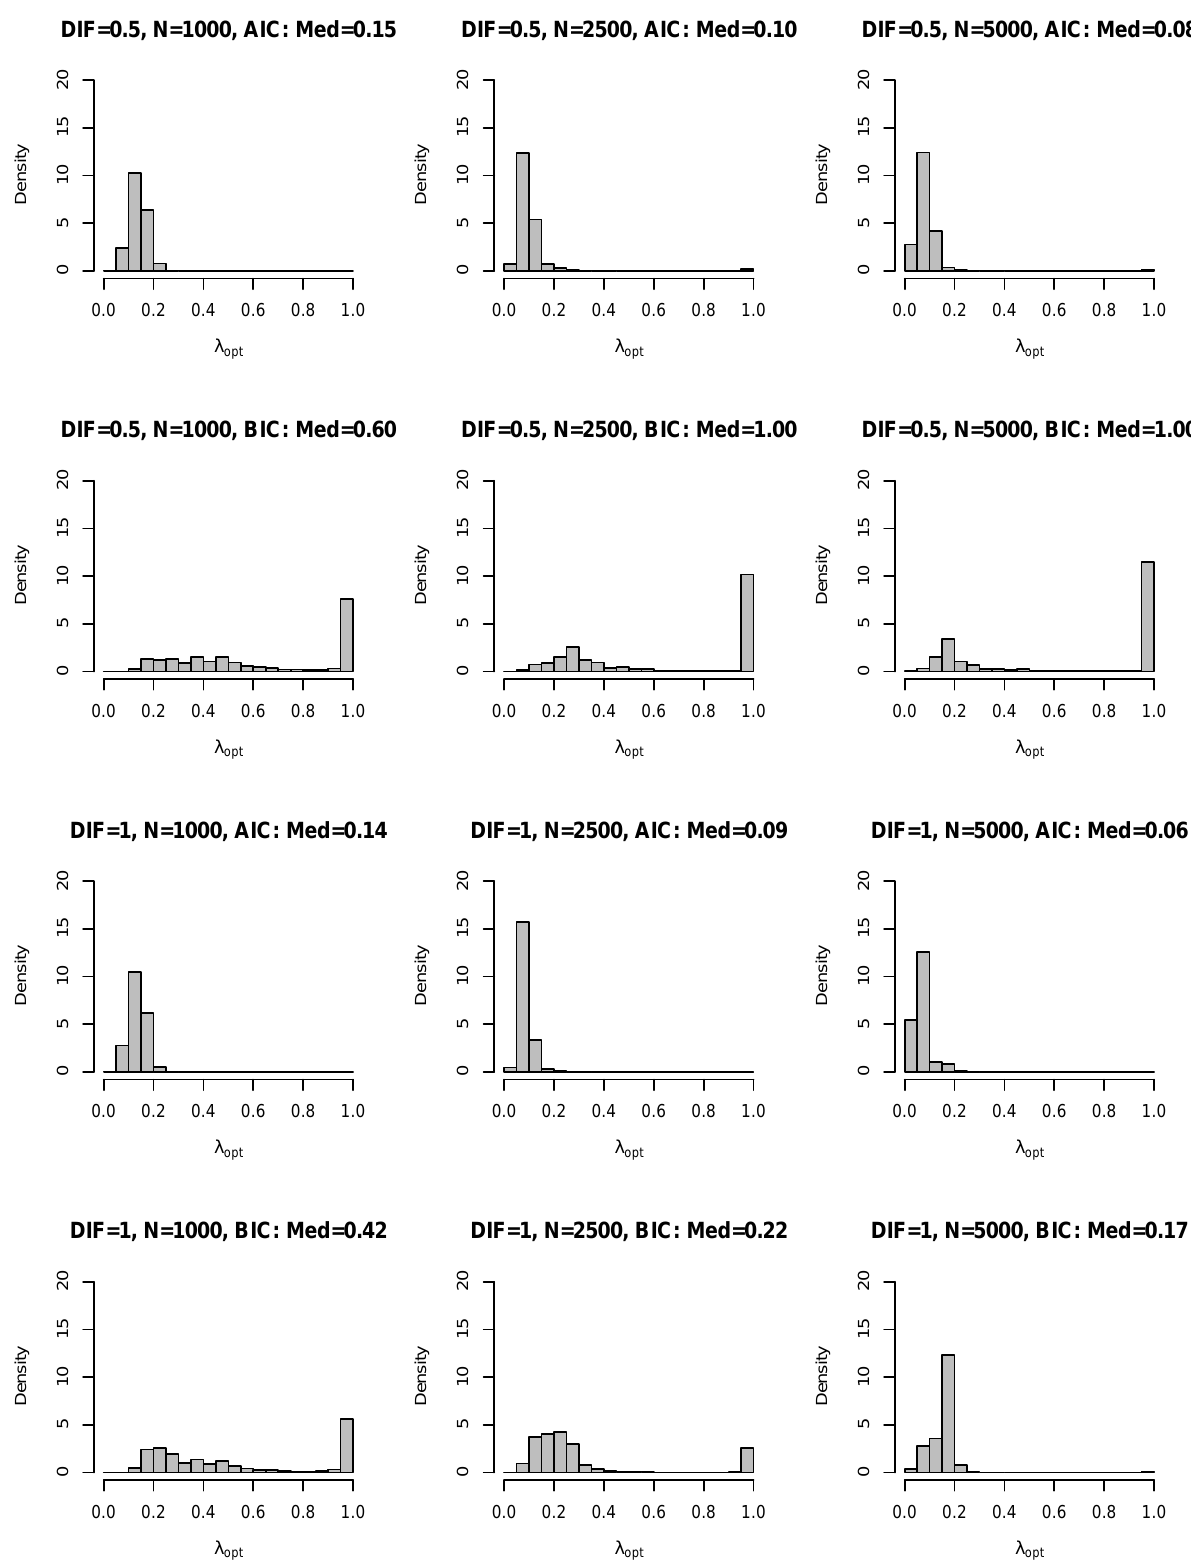
Figure 1. Simulation Study 1: Empirical histograms of optimal regularization parameters λ opt as a function of sample size N , size of DIF effects and the chosen information criterion (i.e., AIC or